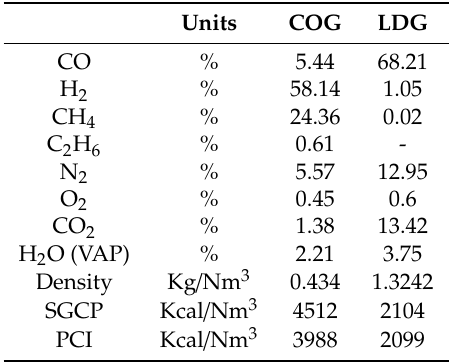
Table 2. Average composition of coke oven gas and Linz–Donawitz converter gas. Source